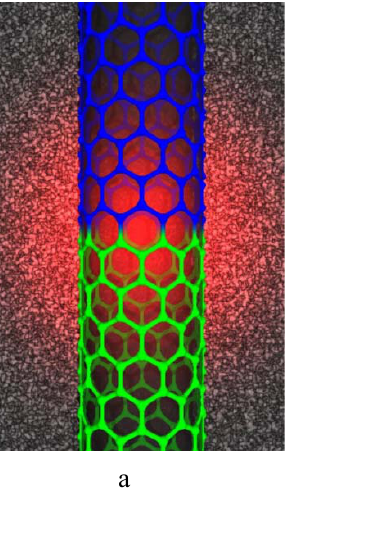
Figure 2. a. Carbon nanotube (1991); b. Boron nanotube (2004); c. Boron α - nanotube (2008).